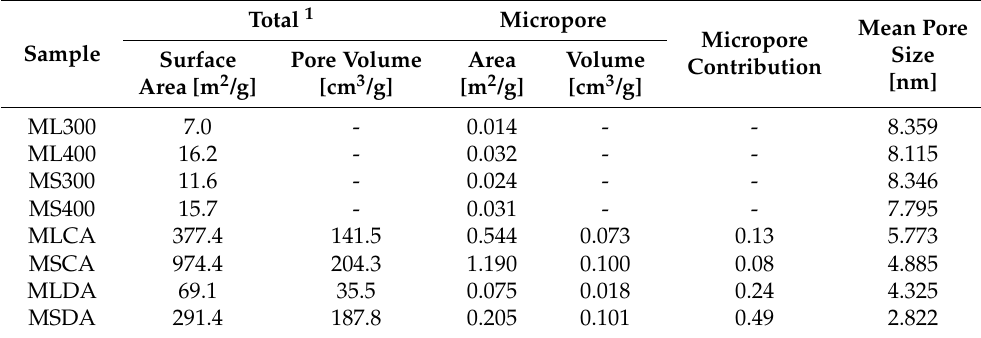
Table 2. Textural parameters of the biochars and activated biocarbons prepared from the mugwort post-extraction